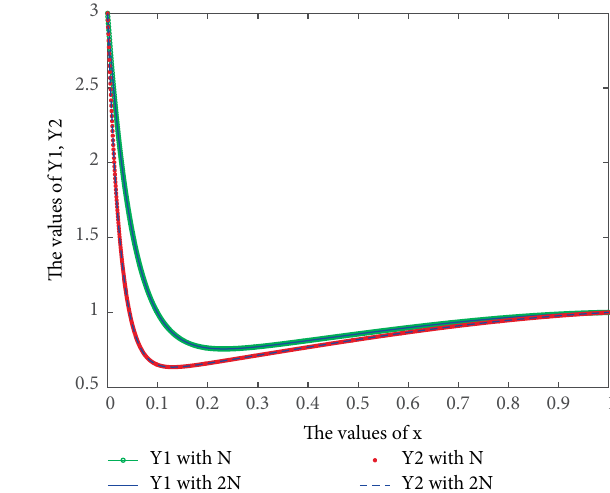
Figure 2: Plot of the solutions of Example 10 for 푁 = 1024